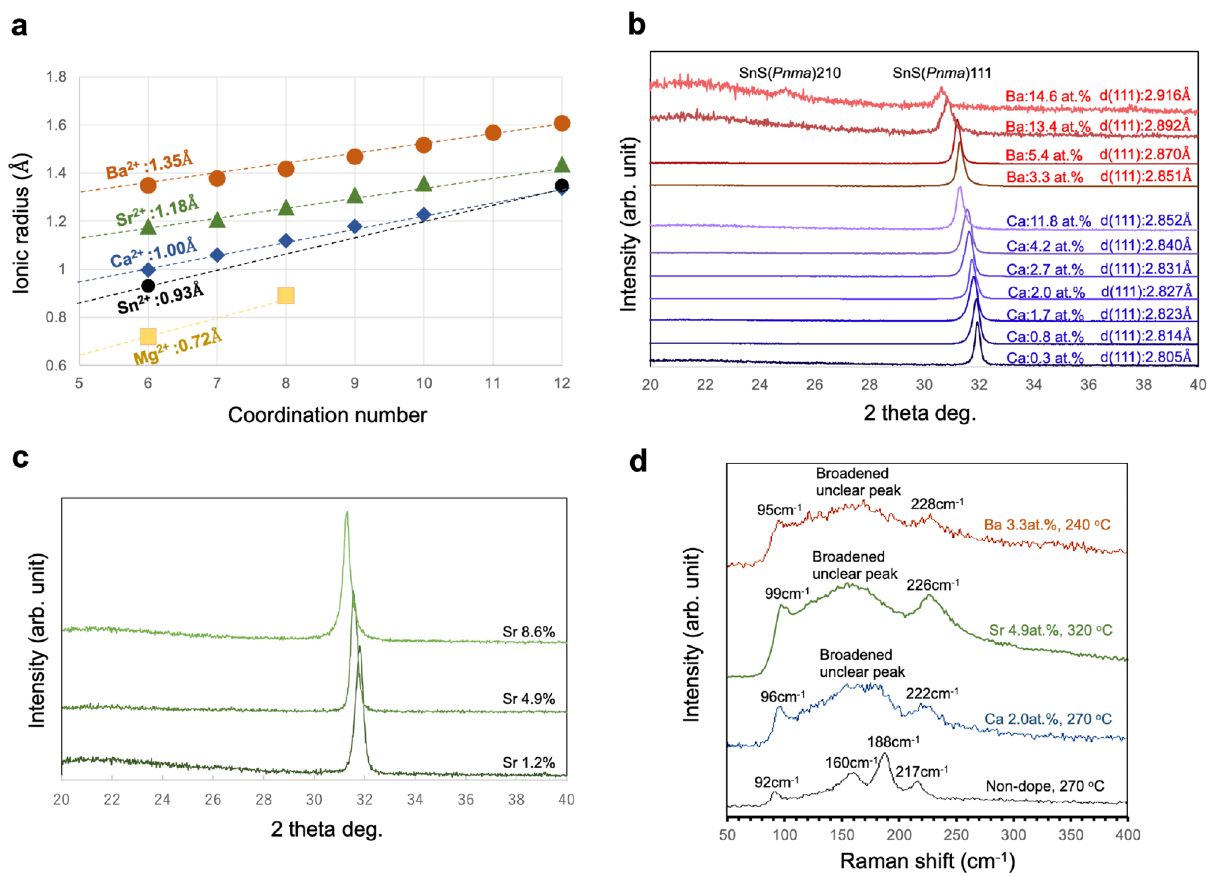
Figure 2. Change in unit cell volume by alloying the SnS film with A.E. elements and confirmation of structure. ( a ) Dependence of the ionic radii of A.E. elements on the C.N. Ba 2+ , Sr 2+ , and Ca 2+ are candidates for expanding the unit cell volume of SnS by replacing the Sn site. ( b , c ) Dependence of the XRD peak position of SnS ( Pnma: JCPDS card number 23-0677 on the amount of alloyed A.E. element (Ba 2+ , Sr 2+ , and Ca 2+ ). The 111 peak continuously shifted towards lower angles with increasing A.E. element content. No peaks aside from 111 were observed except for the highly Ba-alloyed SnS film. ( d ) Raman spectra of Ba-, Sr-, and Ca-alloyed and pure SnS films. Neither film contained any Sn–S phases other than SnS ( Pnma